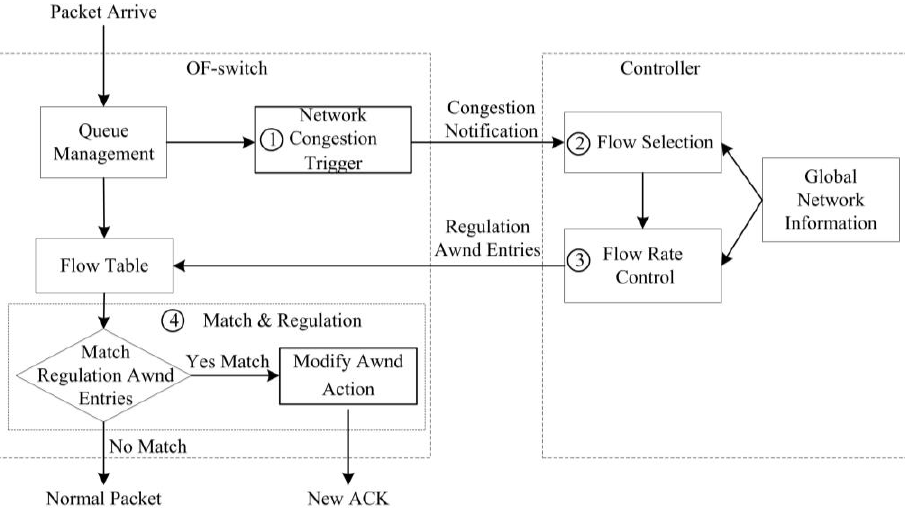
Figure 3. The workflow of SDTCP.